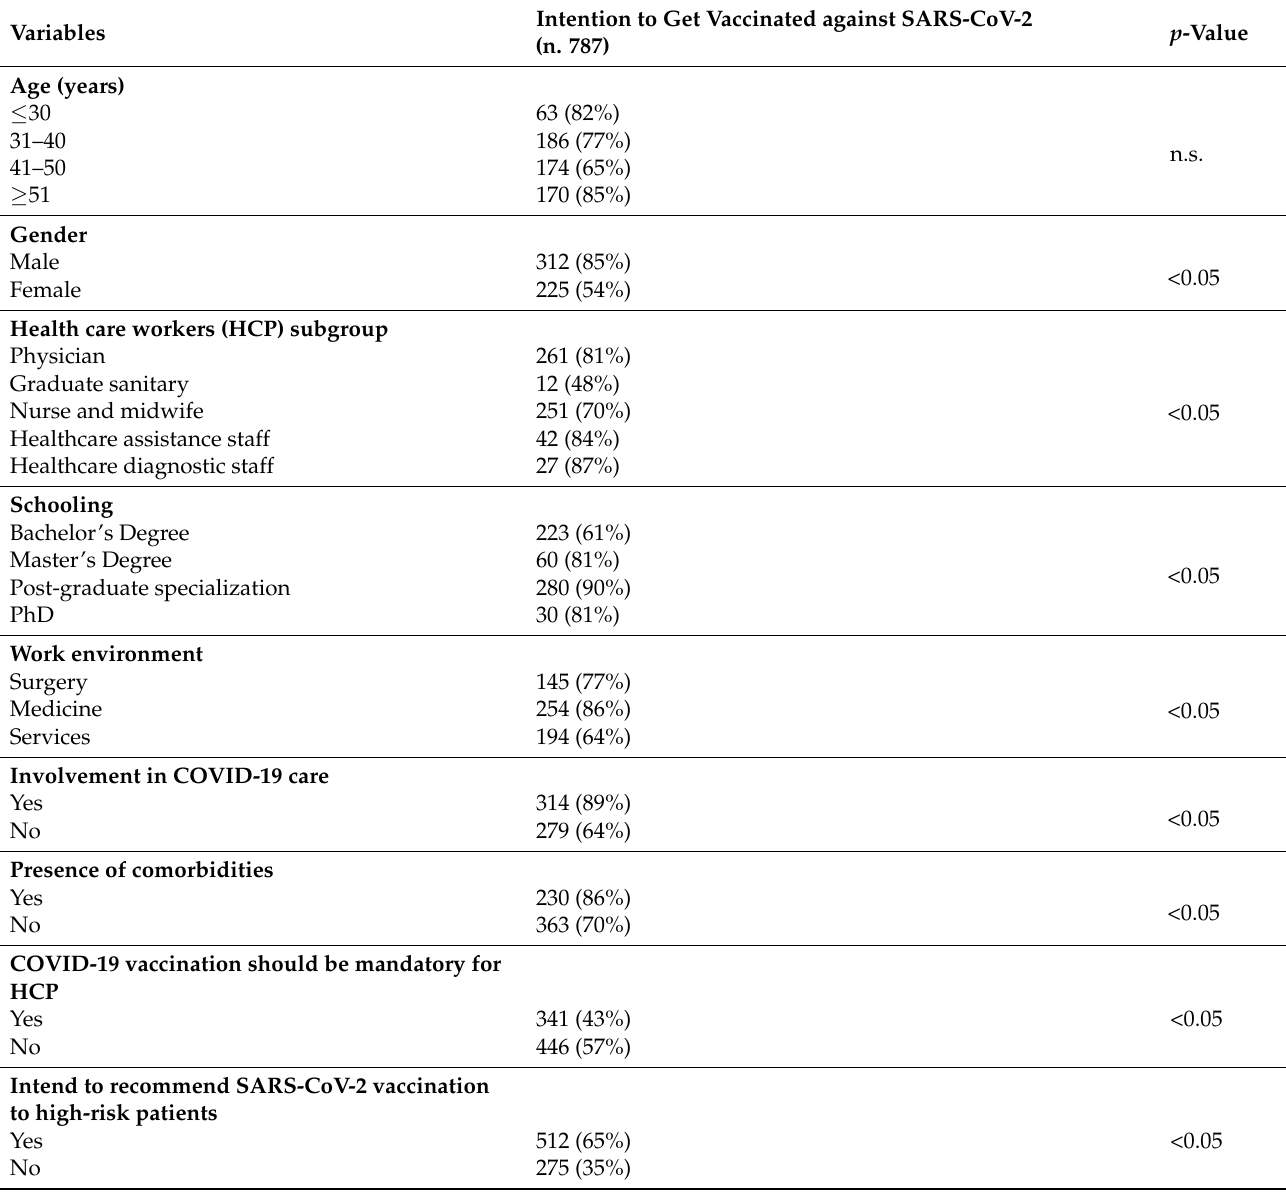
Table 5. Intention and attitudes to get vaccinated against COVID-19 by characteristics of